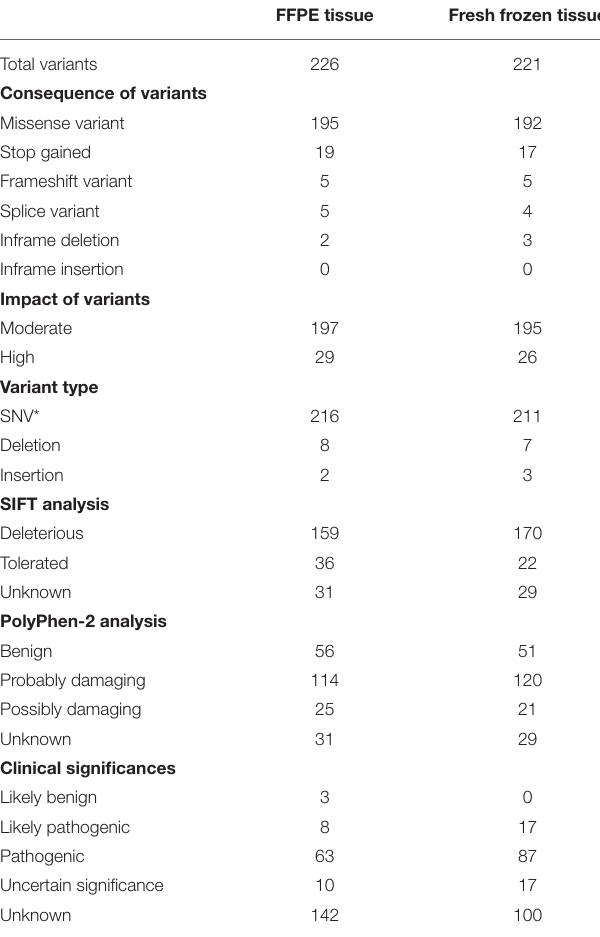
TABLE 5 | Concordance of mutation results between fresh frozen and FFPE tissues, at the gene